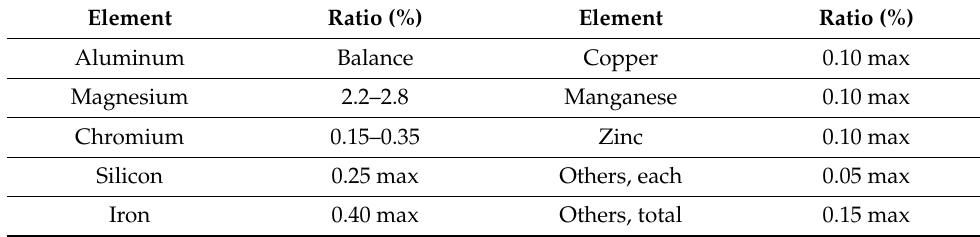
Table 3. Chemical composition of A5052 aluminum